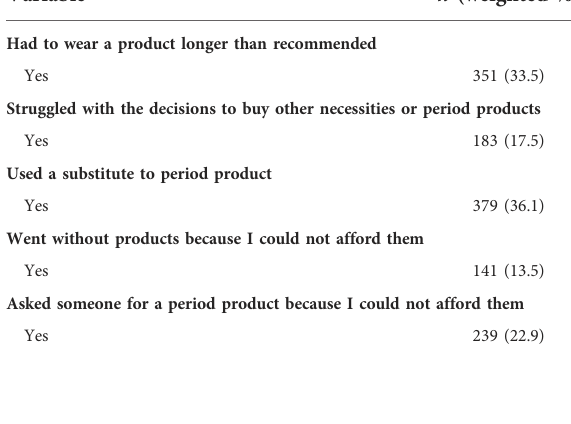
TABLE 2 Period poverty situations. Unweighted ( n